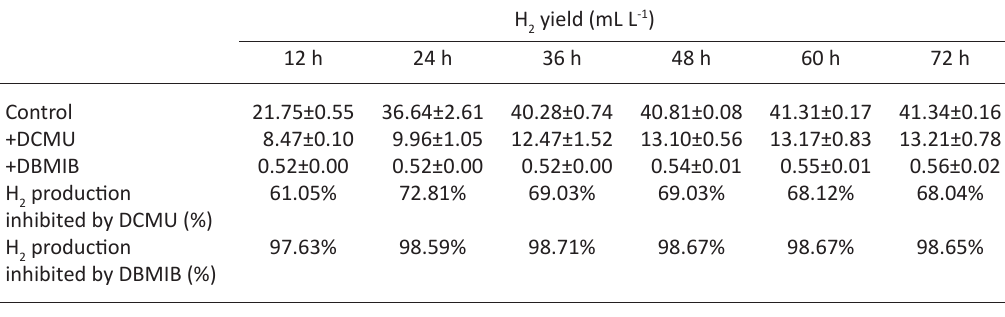
Table 1. Effect of DCMU and DBMIB on H and S- and P-deprivation (TAP-S-P (0.7 mM NH